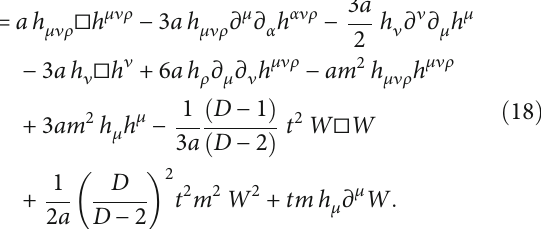
ffiffiffiffiffiffiffiffiffiffiffiffiffiffiffiffiffi 3 D − 1 ð